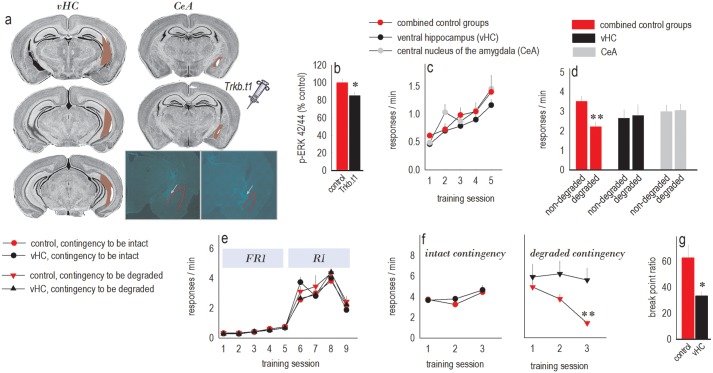
Overexpression of truncated trkB induces habits, makes them harder to “break,” and causes depression-like behavior.(a) We infused a lentivirus expressing truncated trkB (Trkb.t1) or GFP into the vHC and CeA. Large (red) and small (white) infusion sites are represented on images from the Mouse Brain Library [27]. All infusion sites are described in S3 Fig. At bottom right, representative lentiviral GFP expression in the CeA is shown (at gray arrows). The external capsule is highlighted in red, and the image is intentionally overexposed. (b) In Trkb.t1-expressing mice, p-ERK42/44 immunoreactivity was diminished at the infusion site. n = 7–8/group. (c) All mice acquired the instrumental responses. Response acquisition curves represent both responses/min. (d) Trkb.t1 in the vHC and CeA blocked sensitivity to instrumental contingency degradation. Thus, selective Trkb.t1 overexpression recapitulated the long-term effects of adolescent CORT exposure. n = 6–8/Trkb.t1 group; total control = 23. (e) Another group of mice was first trained using a fixed ratio schedule of reinforcement. Then, to build on our findings reported in (d), an RI schedule of reinforcement was applied, with no interruption in training and no differences in responding between groups. (f) In reaction to repeated instrumental contingency degradation training, control mice inhibited a response that was unlikely to be reinforced, their habits “breaking” (“degraded contingency,” right). By contrast, mice with vHC Trkb.t1 failed to inhibit responding. Response rates associated with an intact contingency were unaffected (left). Response rates are represented on 2 plots in the interest of clarity but were compared together by ANOVA. n = 9–10/group. (g) Finally, vHC Trkb.t1 overexpression also decreased responding on a progressive ratio schedule of reinforcement in adulthood, again recapitulating the long-term effects of adolescent CORT exposure. n = 9/group. Bars/symbols = means + SEMs, * p < 0.05, ** p ≤ 0.004. Raw data for this figure can be found in S1 Data. CeA, central nucleus of the amygdala; ERK42/44, Extracellular signal-Regulated Kinase 42/44; p-ERK, phosphorylated ERK; trkB, tyrosine kinase receptor B; trkB.t1, truncated trkB; vHC, ventral hippocampus.